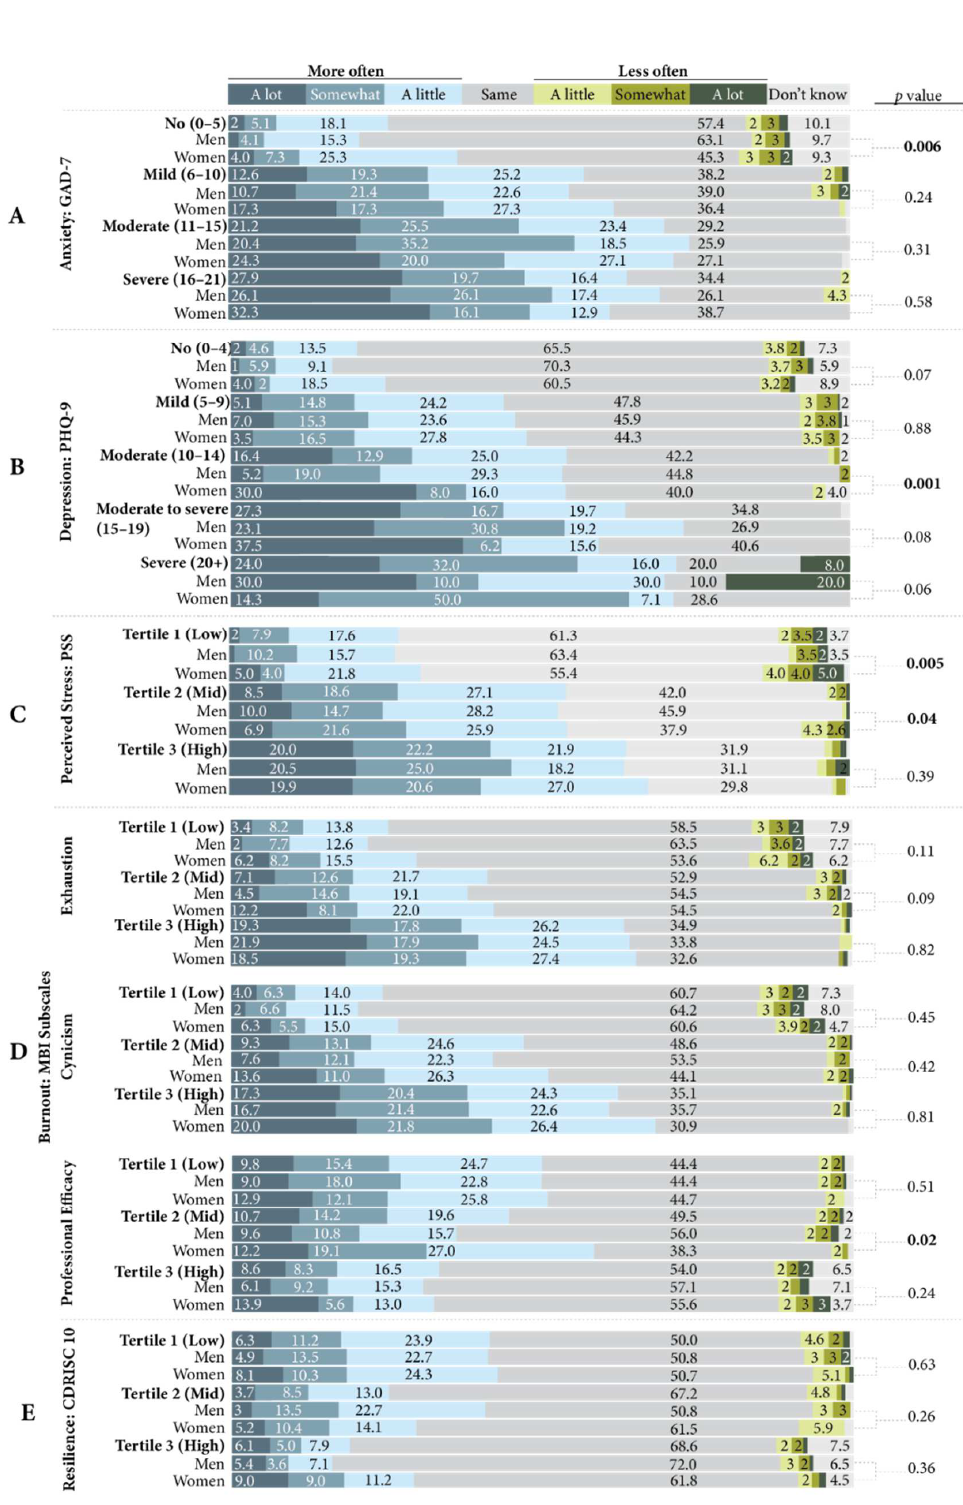
Figure 4. Perceived change in scale symptoms since the pandemic began by scale classification (Generalized Anxiety Disorder-7 (GAD-7) and Patient Health Questionnaire-9 (PHQ-9) or tertile-Perceived Stress Scale (PSS), Maslach Burnout Inventory–General Survey (MBI), Connor Davidson Resilience Scale-10 (CD-RISC 10)), and comparisons by gender.